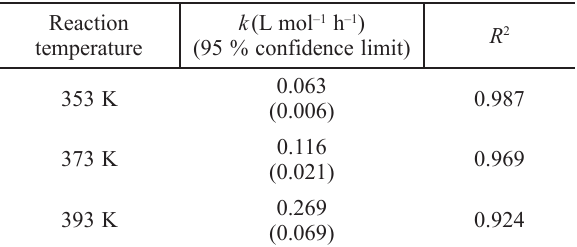
5 – Kinetic parameters for the power law model given by eq. 1 using integral analysis for n = 2. The 95 % confidence limits are given in parenthesis and R 2 values are also given in the last column.